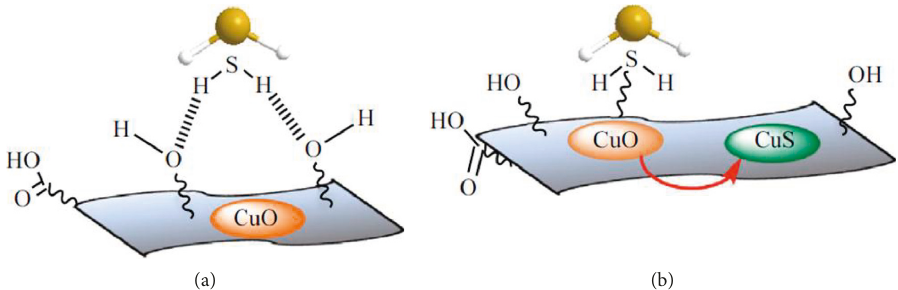
Figure 8: Mechanism of H 2 S adsorption on reduced graphene/CuO composite through initial physisorption (a) and subsequent chemisorption (b) (image taken from